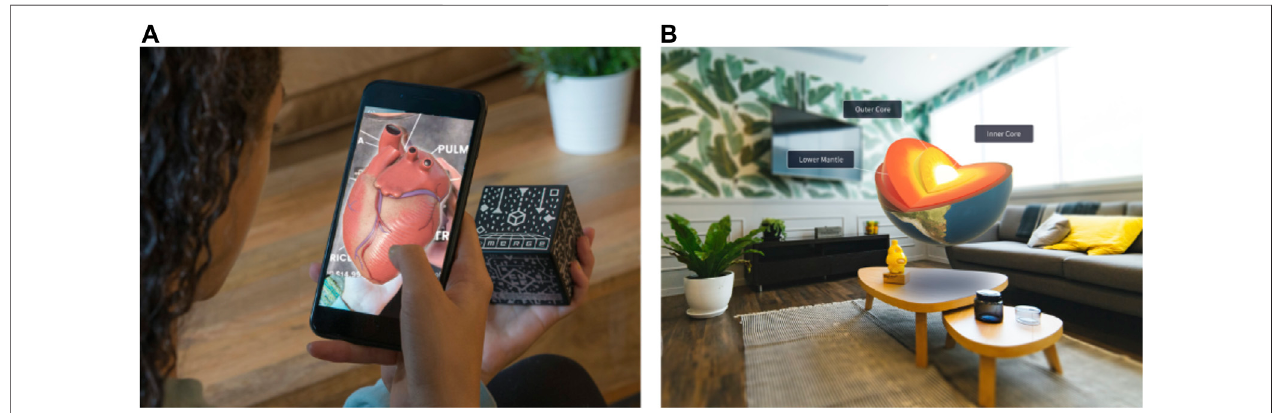
FIGURE 2 | MERGE Cube (A) and Jigspace (B)